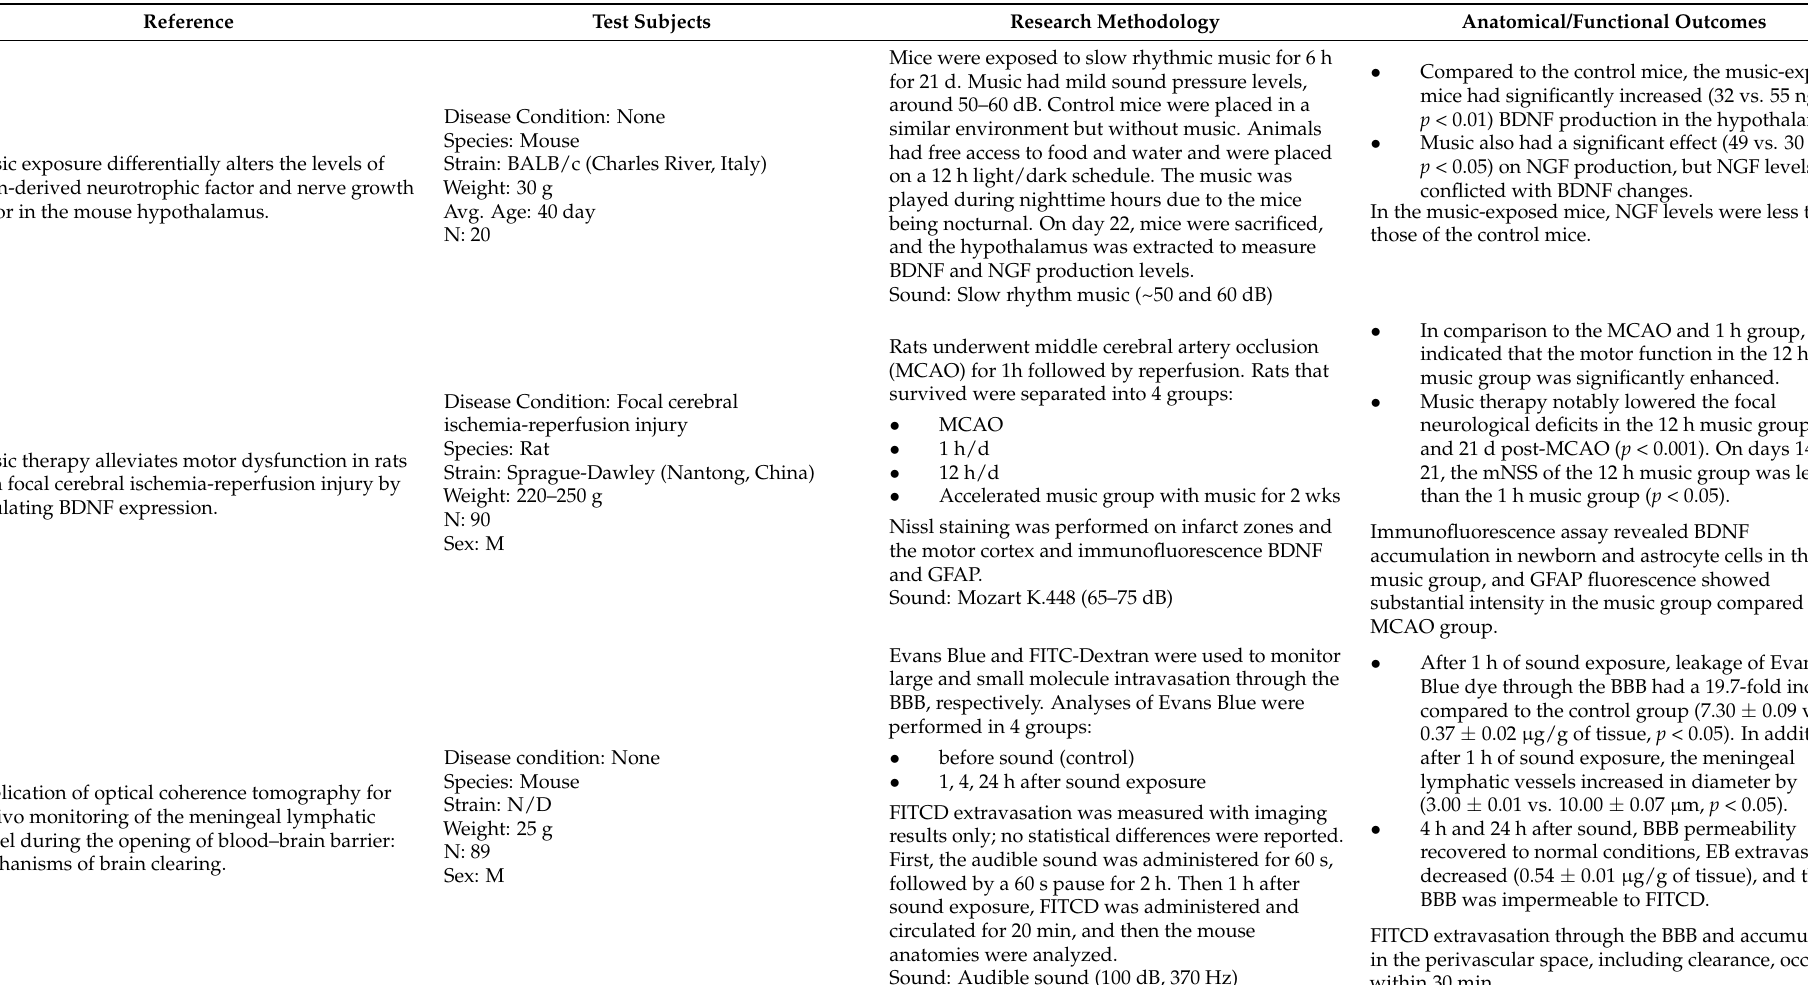
Table 1. Studies provide insights into music/sound and rodents’ meningeal lymphatic/glymphatic system. Overview of all studies that showcase the effect of music on the glymphatic system. Each study is broken down based on the overall purpose and the selected sample, design, and study outcomes. Reference Test